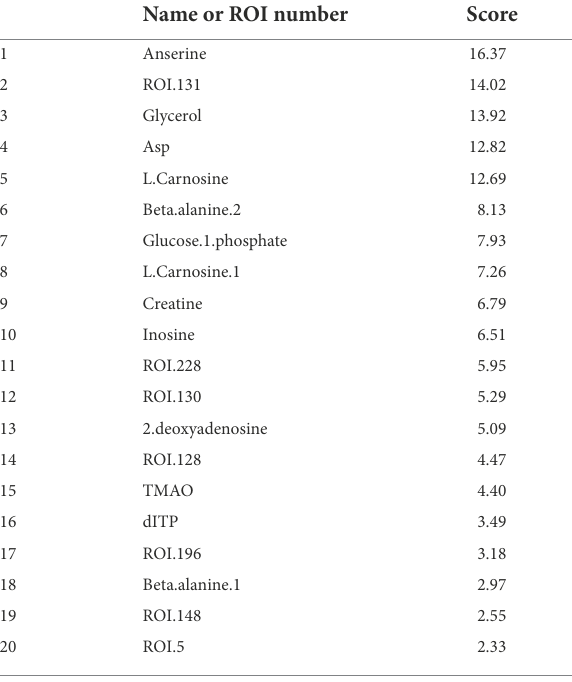
The score indicates gini impurity, a higher value of which indicates a more important variable for classification. Signals identified in our database are named. Unidentified signals are marked with ROI numbers.